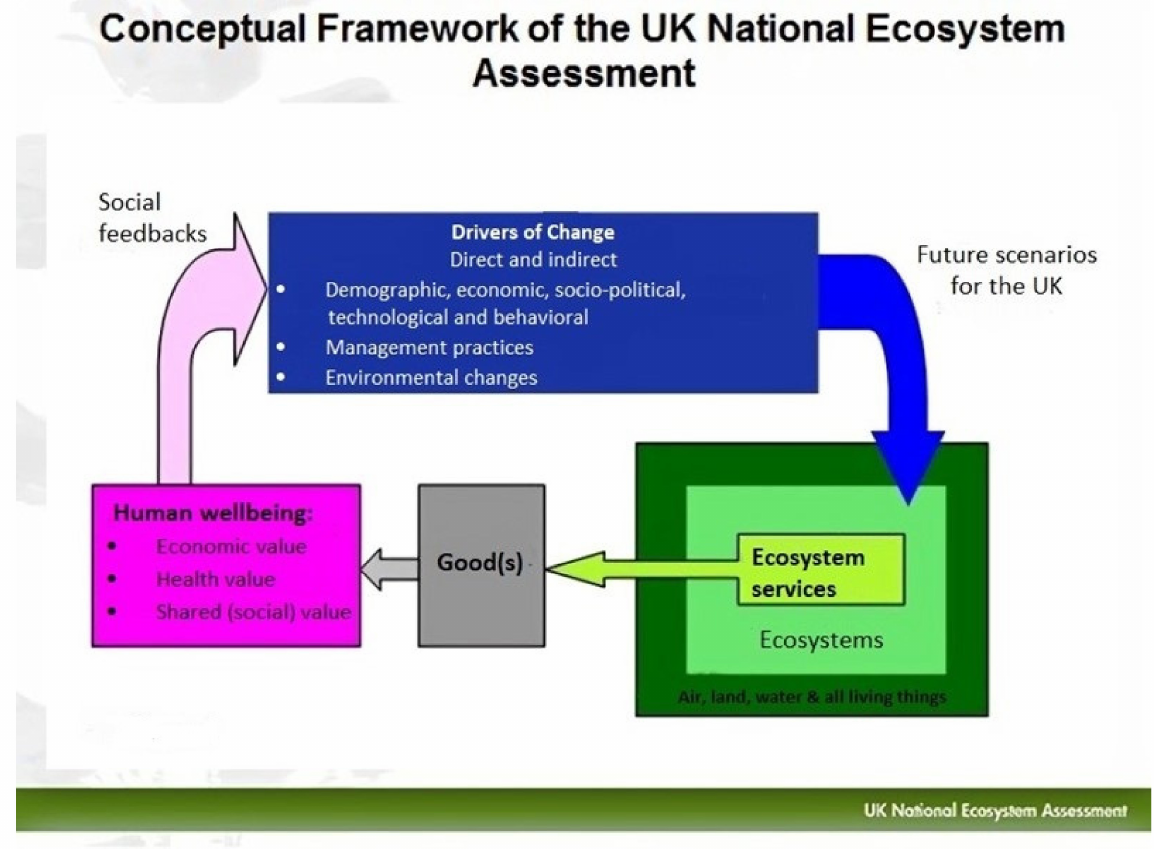
Figure 19. Conceptual framework of the UK National Ecosystem Assessment. Source: UK National Ecosystem Assessment 2011 UNEP-WCMC Cambridge.